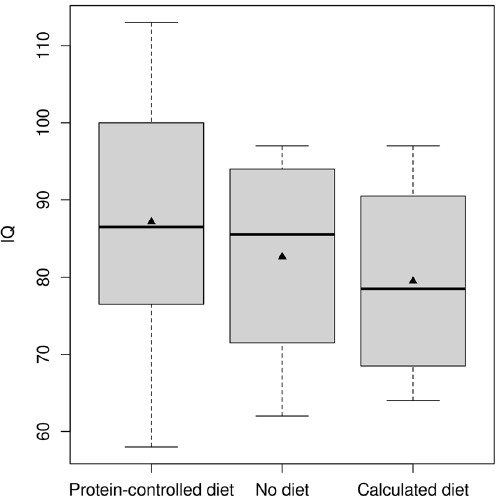
Figure 4. Maintenance treatment and full scale IQ in patients beyond age six years. Results did not differ between patients following recommended protein-controlled diet (median [horizontal line in box] IQ 87; IQR 77–100), patients continuing calculated diet beyond age six years (median [IQR] 79 [71–87]) and patients not complying to any diet (median [IQR] 86 [74–94]; p = 0.563). Black triangles indicate mean